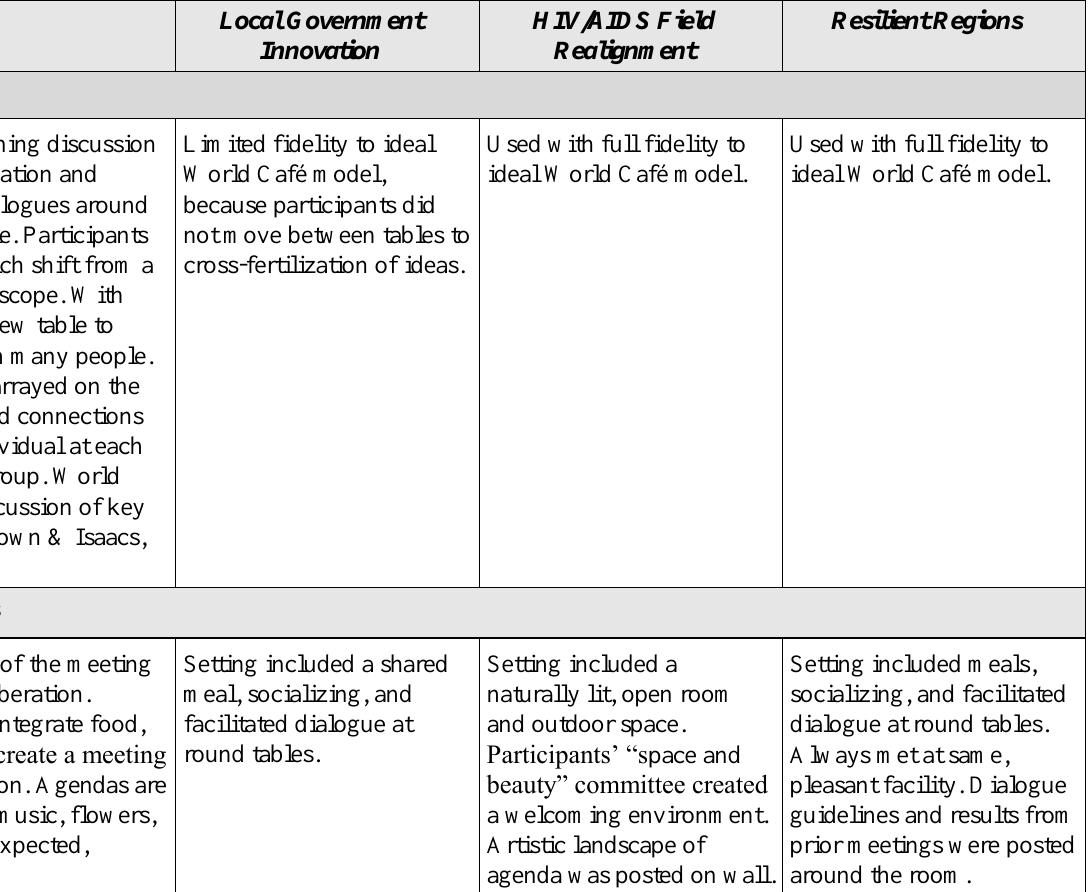
Table 2. Deliberative resources in use across all deliberative process case